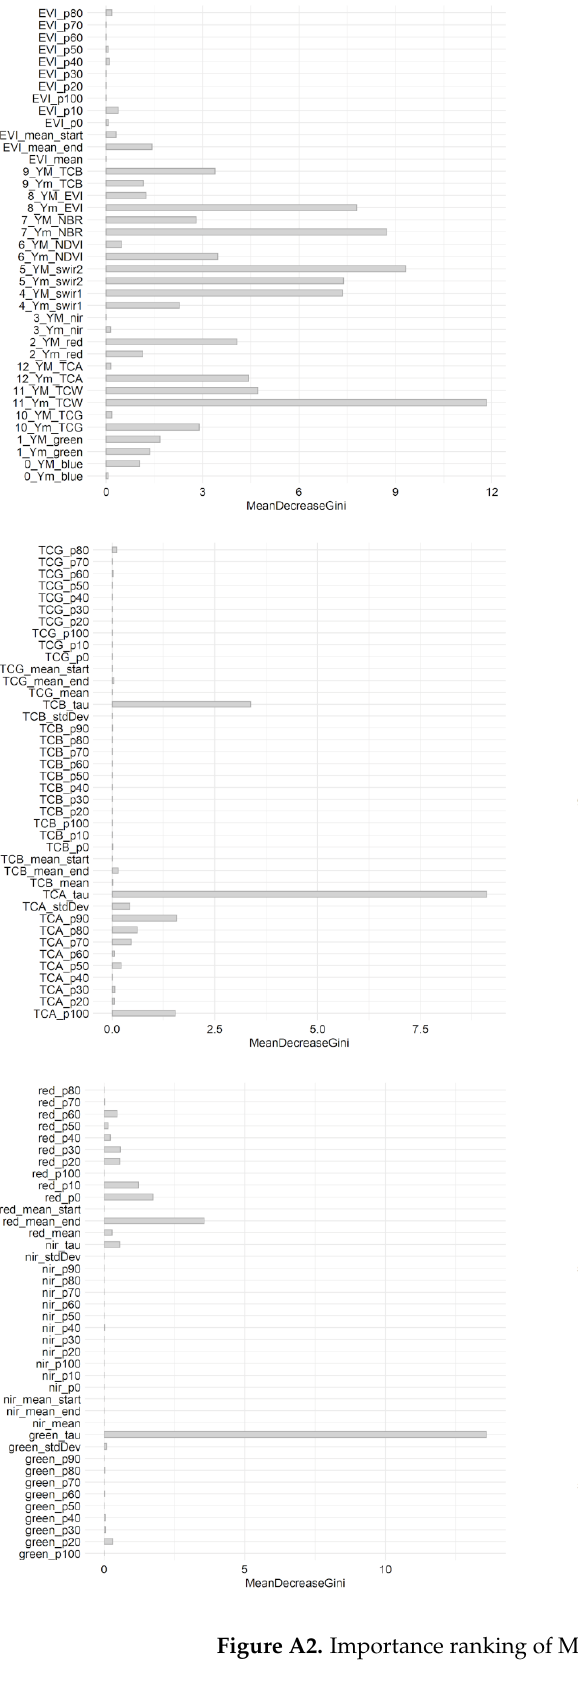
Figure A2. Importance ranking of MDG values of the 234 temporal predictors .